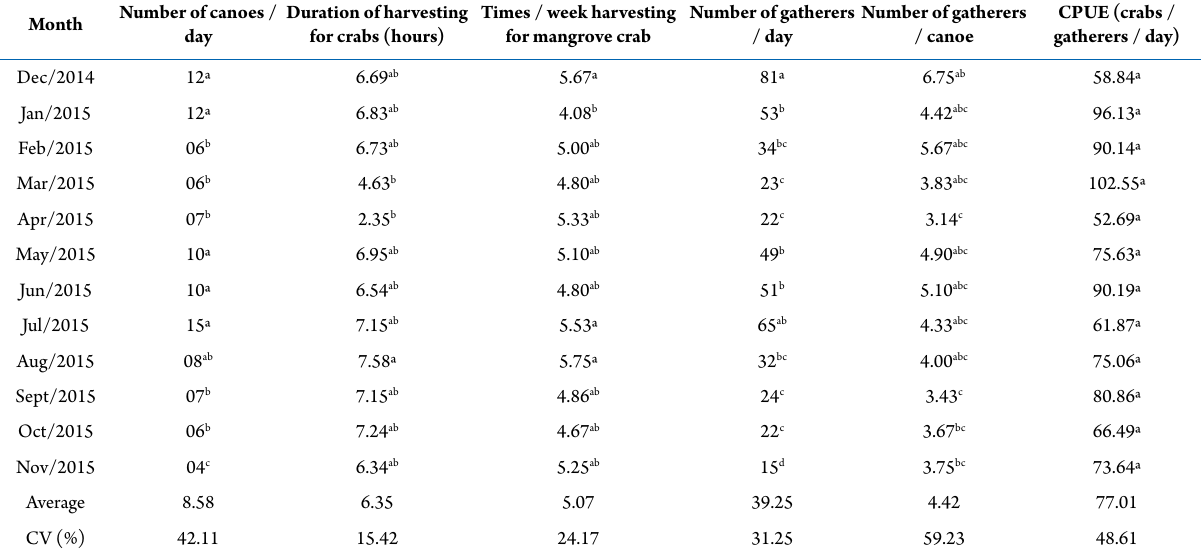
Table 1. General aspects of the Ucides cordatus harvesting in the Parnaíba River Delta, Brazil. Average followed by different letters in the columns indicates statistical difference (p < 0.05). N = 84. Source: drafting of the authors.